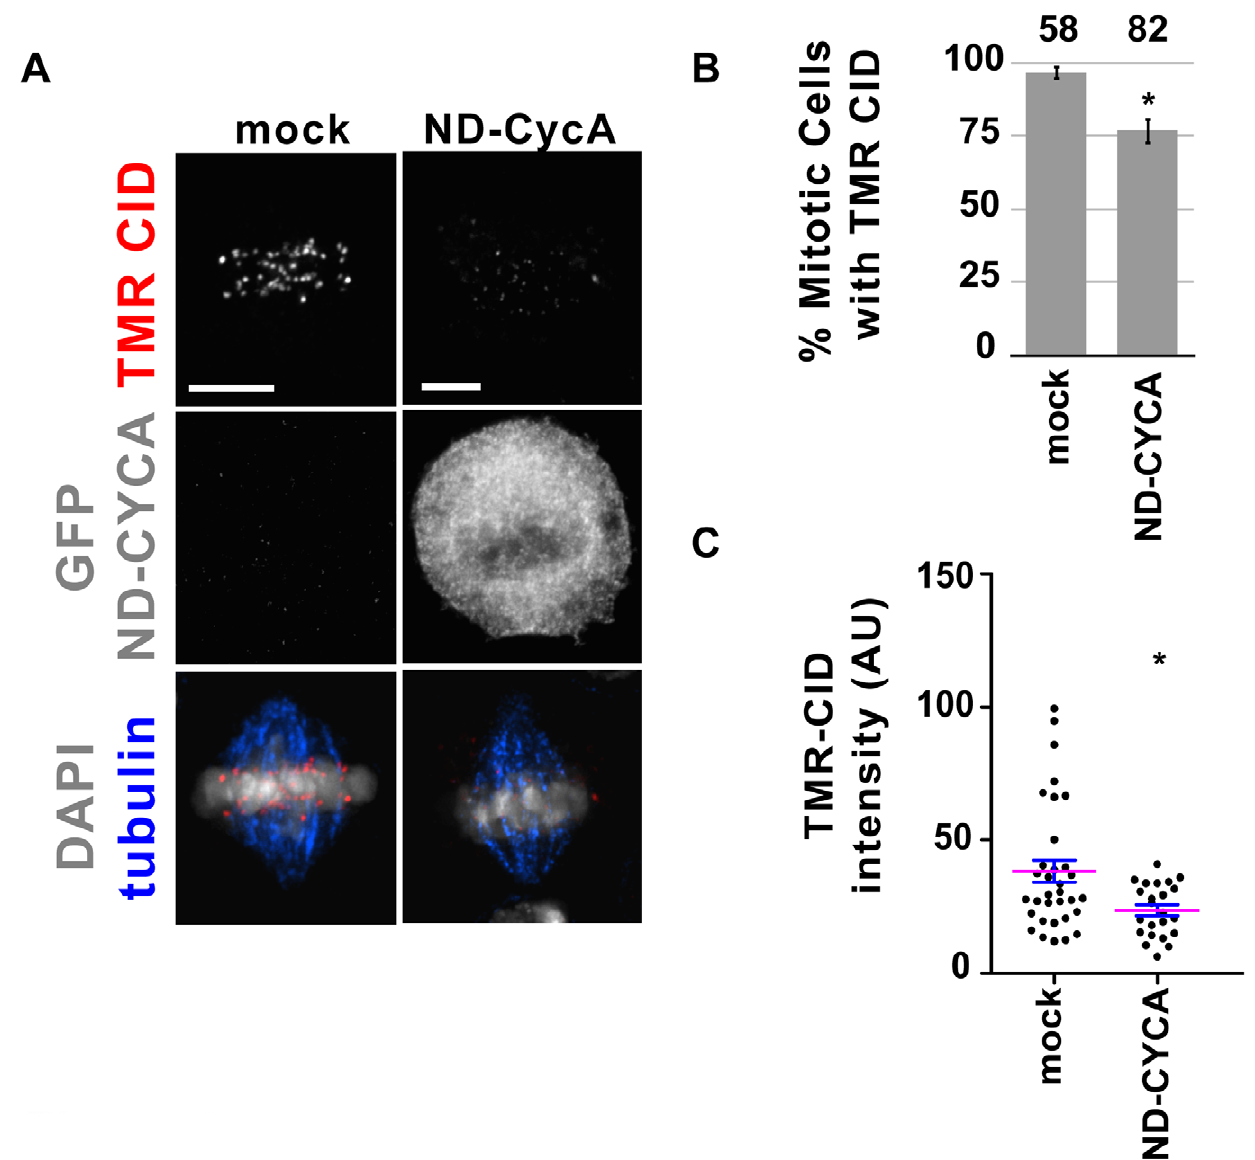
Figure 7. Presence of non-degradable CYCA in metaphase reduces the efficiency of CID recruitment. A) Representative images of metaphase cells transfected without plasmid (mock) and with GFP- D 55-CYCA. After transfection, SNAP-CID S2 cells were BTP-blocked and TMR- labeled 4 h later. Cells transfected with GFP- D 55-CYCA showed reduced SNAP-CID recruitment. TMR-CID is shown in red, GFP- D 55-CYCA in gray, tubulin in blue and DAPI in gray. Bar=5 m m. B) Percent of mitotic cells (y-axis) displaying centromeric TMR-CID 4 h following the BTP-block. Fewer cells recruited new CID when transfected with GFP- D 55-CYCA (n=82) compared to mock-transfected cells (n=58) (* p , 0.05; Fisher’s exact test). Error bars represent standard error. C) Distribution of the average TMR-CID intensity in mock and transfected cells. Each dot represents individual cells. Mean (magenta) and standard error bars are shown (* p , 0.05; Fisher’s exact test). AU=arbitrary units.